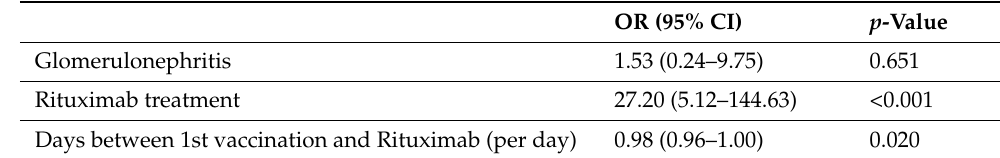
Table 3. Multivariate analysis of risk factors for non-response in CKD patients. OR odds ratio, CI confidence